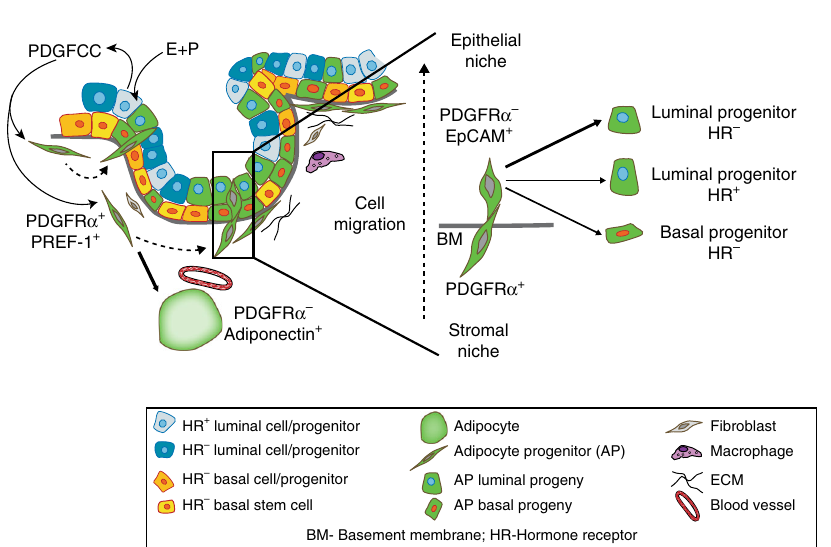
Fig. 8 Model illustrating the plasticity of stromal progenitors in the mammary gland. The mammary stroma is home to PDGFR α + PREF-1 + mesenchymal progenitor cells that are found in close promixity to the parenchymal epithelium. These cells can differentiate into adipocytes (Adiponectin + ) in the mammary fat pad, or switch to an epithelial cell fate (EpCAM + ). To undergo this stromal-to-epithelial transition, mammary epithelial cells are stimulated by adult sex hormones such as estrogen and progesterone (E + P) to secrete PDGFCC, a PDGFR α ligand, which induces chemotactic migration of PDGFR α + mesenchymal progenitors into the epithelial niche. In the epithelium, these stroma-derived cells generate epithelial progeny, primarily giving rise to the hormone receptor (HR)- negative luminal lineage in the adult during epithelial